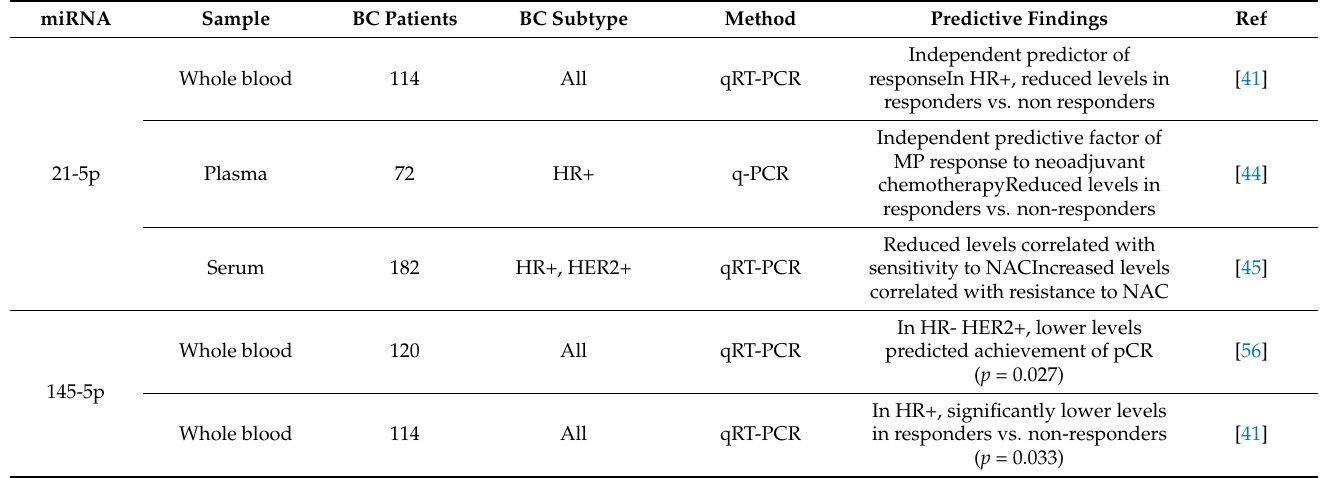
Table 2. Main findings on circulating miRNAs as predictive markers in BC patients undergoing